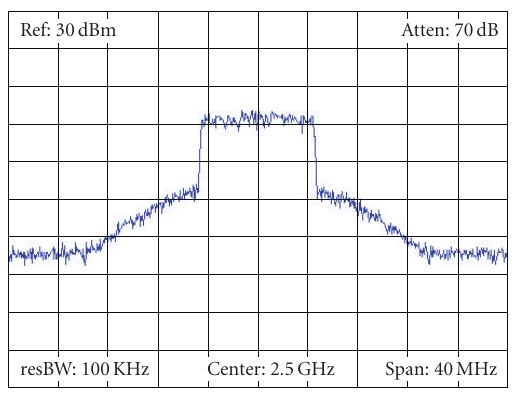
Figure 11: QPSK WiMax TX spectrum at +21dBm output power. Table 1: Measurement results for WiMAX Wave 2 Category 1 mobile